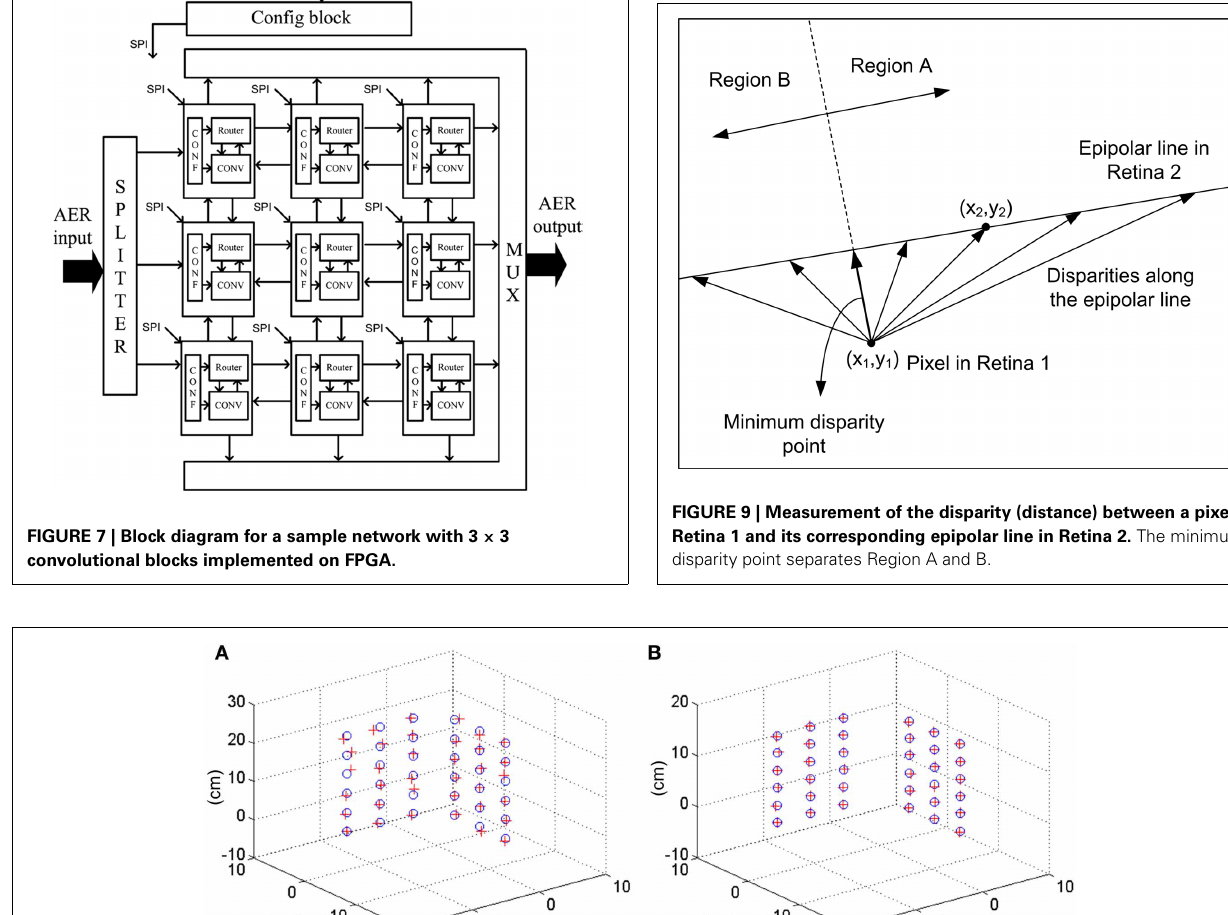
the reconstructed coordinate. (C,D) Show the measured errors absolute value in cm for approaches 1 and 2, respectively. Red lines represent the mean